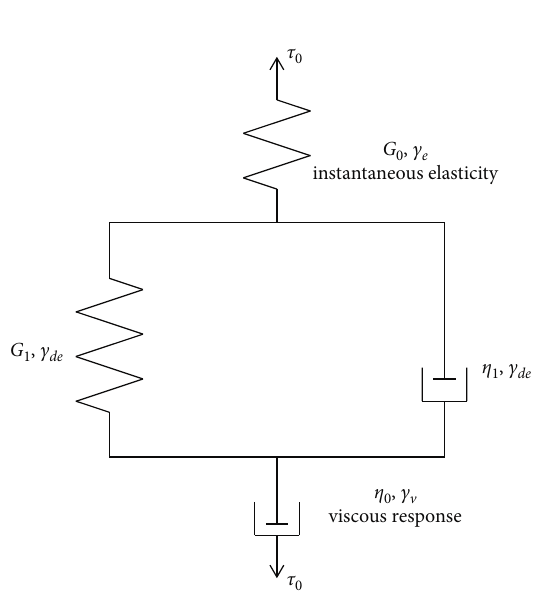
Figure 2: Burgers rheological